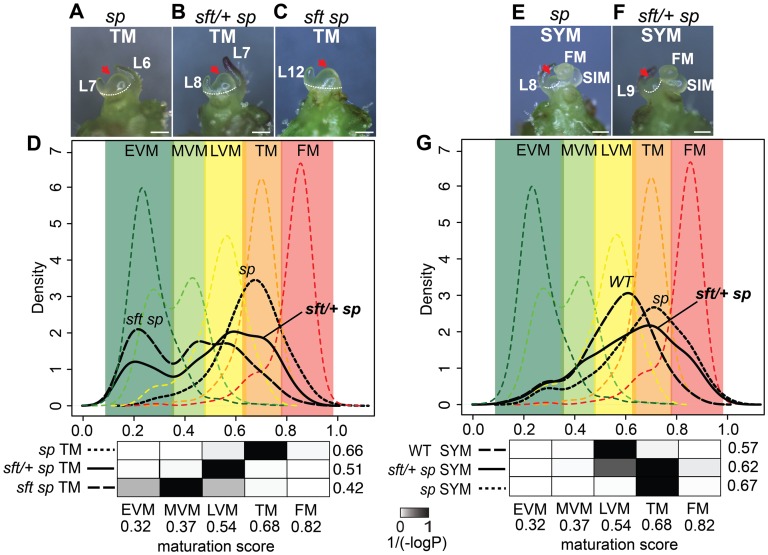
Transcriptome profiling reveals a semi-dominant delay in meristem maturation from sft/+ heterozygosity.(A–C) Stereoscope images showing morphology and dissection (white dashed line) of the TM stage used for mRNA-Seq from sp (A), sft/+ sp (B) and sft sp (C) genotypes. Scale bar: 100 um. Red arrows highlight identical TM morphologies. L: leaf primordium number. The additional leaf primordium at the sft/+ sp TM is consistent with the one leaf delay in primary shoot flowering time (Figure 2). (D) DDI quantification of maturation scores for sp, sft sp, and sft/+ sp predicted from the WT PSM meristem maturation atlas [34]. Colored dashed curves indicate maturation stages for the 5 PSM stages used for calibration EVM, MVM, LVM, TM and FM [the Early, Middle, and Late Vegetative Meristems, Transition Meristem and the Flower Meristem]. Colored areas define boundaries of these stages estimated from the curves. Maturation scores are derived from 637 DDI-selected marker genes (Dataset S3). Student's t-tests are presented as heat-maps of scaled 1/(−log10
P) values below each graph, and associated numbers to the right indicate average maturation scores for the predicted meristems. Darker color indicates greater similarity in maturation state. Note the statistically intermediate TM maturation state of sft/+ sp relative to sft sp and sp, indicating sft/+ heterozygosity causes a semi-dominant delay in the primary flowering transition. The presence of more than one peak along the curves of the sft sp and sft/+ sp genotypes reflect mixed maturation states for these TMs, as different subsets of marker genes are driving different maturation stage estimates that translate to less uniform maturation patterns. (E–F) Stereoscope images showing morphology and dissection of the first sympodial shoot meristem (SYM) used for mRNA-Seq profiling in sp (E) and sft/+ sp genotypes (F). Meristems and leaf primordia are marked as in Figure 2. (G) DDI quantification of SYM maturation scores from sp, sft/+ sp, and WT using the PSM stages as calibrations. Maturation scores for sft/+ sp, sp and WT indicate an intermediate maturation state for the SYM of sft/+ sp plants, mirroring the delay in the PSM. P-value heat maps are shown below along with average maturation scores to the right.